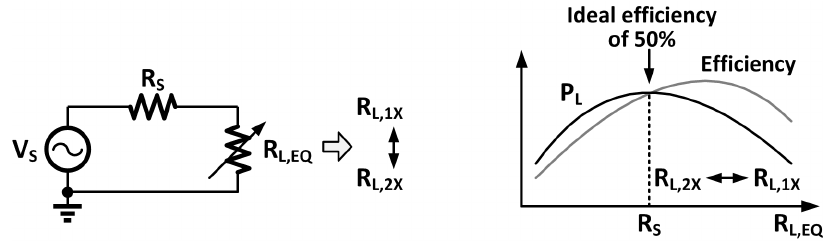
Figure 6. Illustration of the relationship of load impedance, output power, and efficiency.